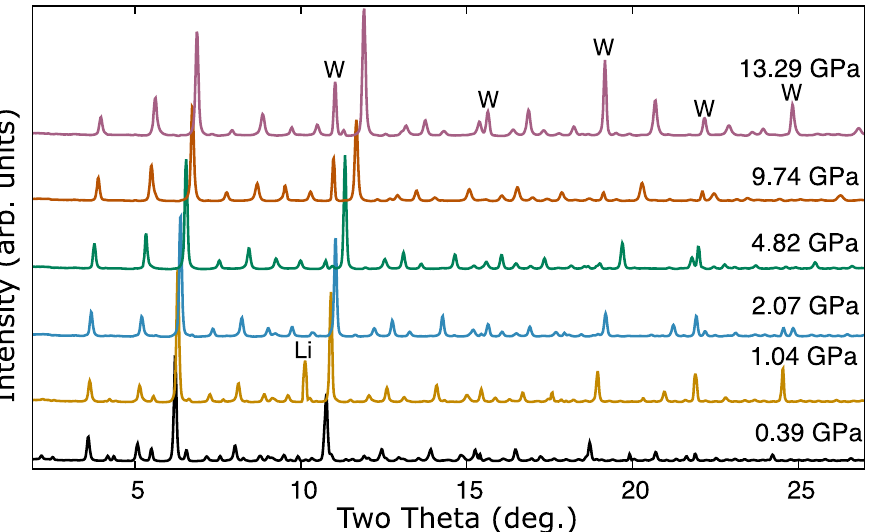
Figure 6. Pressure evolution of the background subtracted integrated diffraction patterns of the lithium– palladium–hydrogen system at ambient temperature. The peaks marked W in the highest trace are due to tungsten and are present at similar angles in some lower pressure traces. A strong lithium peak is also marked at 1.04 GPa .